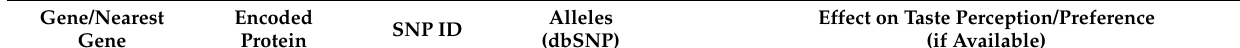
Figure 1. PRISMA flowchart of study selection process [22]. Table 1. Description of single nucleotide polymorphisms included in the